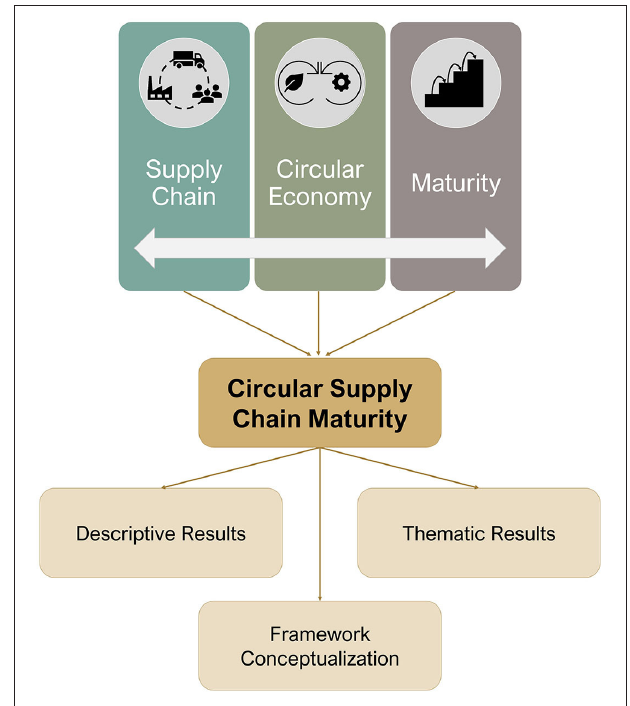
FIGURE 1 | Research